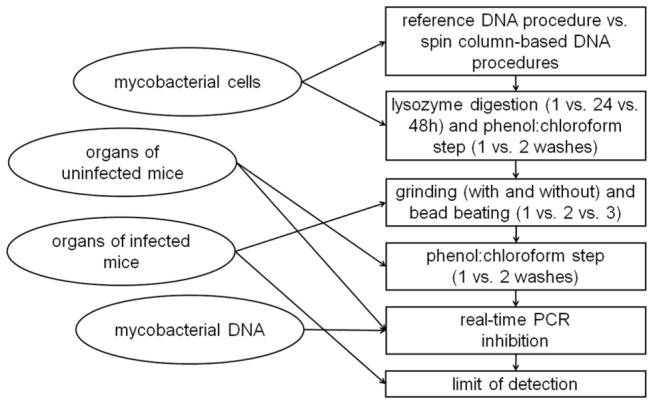
Flow diagram describing organization of samples (circles) and compared factors (rectangles) used for improvement of mycobacterial DNA detection by real-time PCR in tissues.